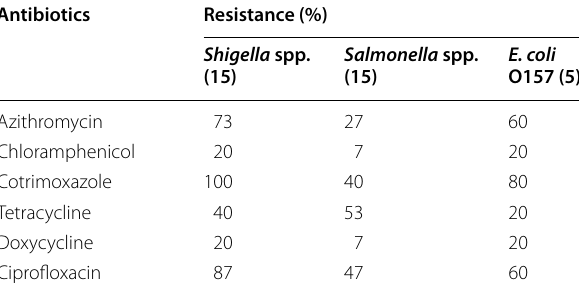
Table 2 High level of resistance against six clinically used antibiotics showed by Shigella spp., Salmonella spp., and E. coli